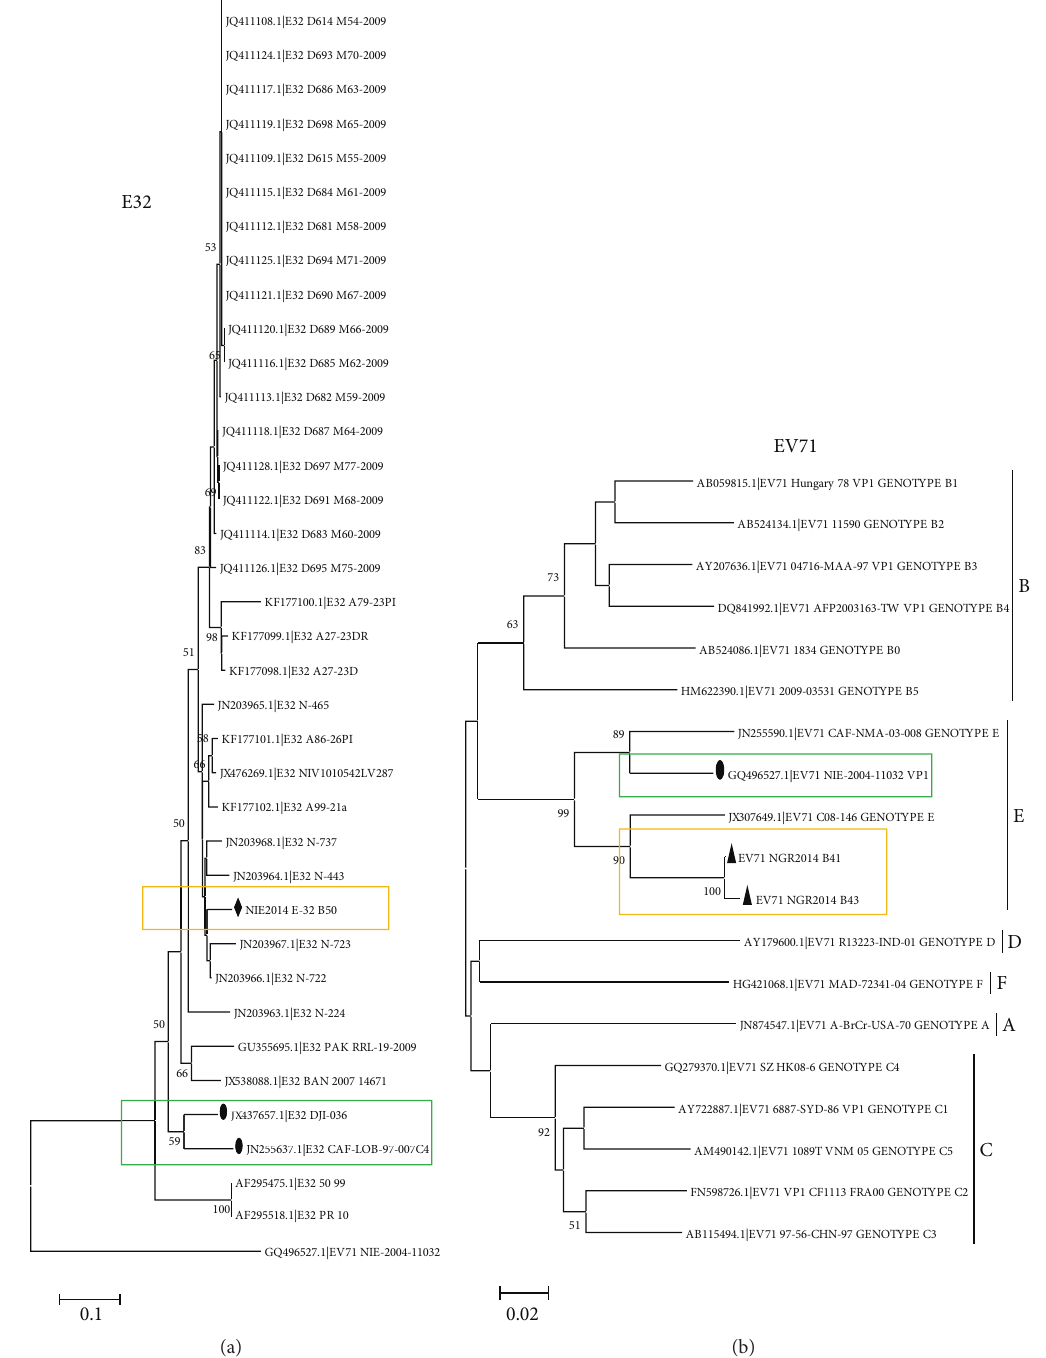
Figure 3: Phylogenetic relationship of recovered E32 (a) and EV71 (b) strains. The phylogram is based on alignment of the partial VP1 sequences. The newly sequenced strains and previous strains from the region are highlighted with black triangles or diamonds and circles, respectively. The GenBank accession number of the strains is indicated in the phylogram. Bootstrap values are indicated if >